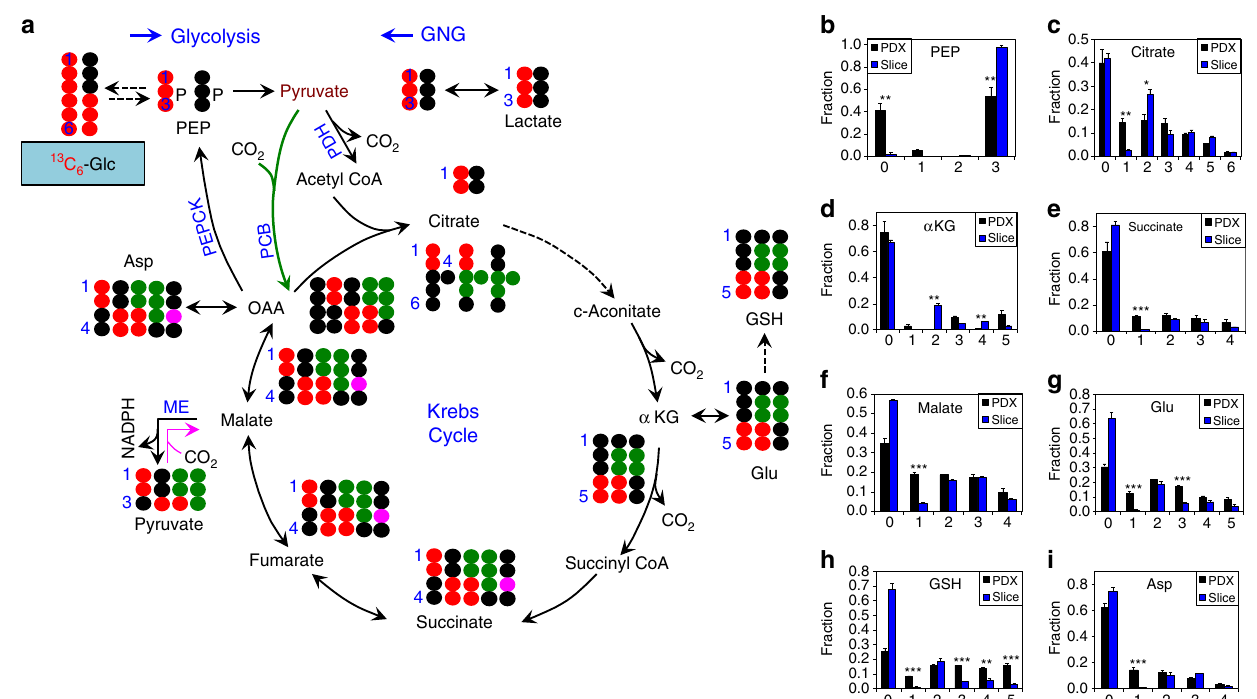
Fig. 3 A PDTX model of NSCLC shows attenuated glycolysis and enhanced malic enzyme activity and use of non-Krebs cycle-derived α KG for Glu/GSH synthesis relative to the corresponding ex vivo tissue culture model. Mice bearing F0 PDTX ( n = 3) from patient UK025 were fed the 13 C 6 -Glc enriched liquid diet for 18 h (cf. Fig. 1) before necropsy. Tumor tissues were dissected, weighed, and fl ash-frozen in liquid N 2 . The freshly thin-sliced UK025 tumor tissues were cultured ex vivo in 13 C 6 -glucose for 24 h before fl ash-frozen in liquid N 2 . Both sets of tissues were processed and analyzed by IC-UHR-FTMS as described in Methods. a Tracing of glucose carbon through glycolysis, gluconeogenesis ( GNG ), the Krebs cycle, malic enzyme (ME) reactions, and synthesis of Glu/GSH. Not all possible labeled metabolites are shown. Black circle: 12 C; red circle, green circle: 13 C from pyruvate dehydrogenase (PDH) and pyruvate carboxylase (PCB)-initiated Krebs cycle reactions, respectively; pink circle: 13 C derived from ME reaction; PEPCK: PEP carboxykinase. b - i fractional enrichments in the isotopologues of phosphoenolpyruvate (PEP), citrate, α -ketoglutarate ( α KG), succinate, malate, Glu, reduced glutathione (GSH), and Asp, respectively. The x-axis denotes the number of 13 C atoms present in each compound. Values shown are mean ± SEM ( n = 3). * 0.01 < P < 0.05; ** 0.001 < P < 0.01; *** P < 0.001, two-tailed t -test (see